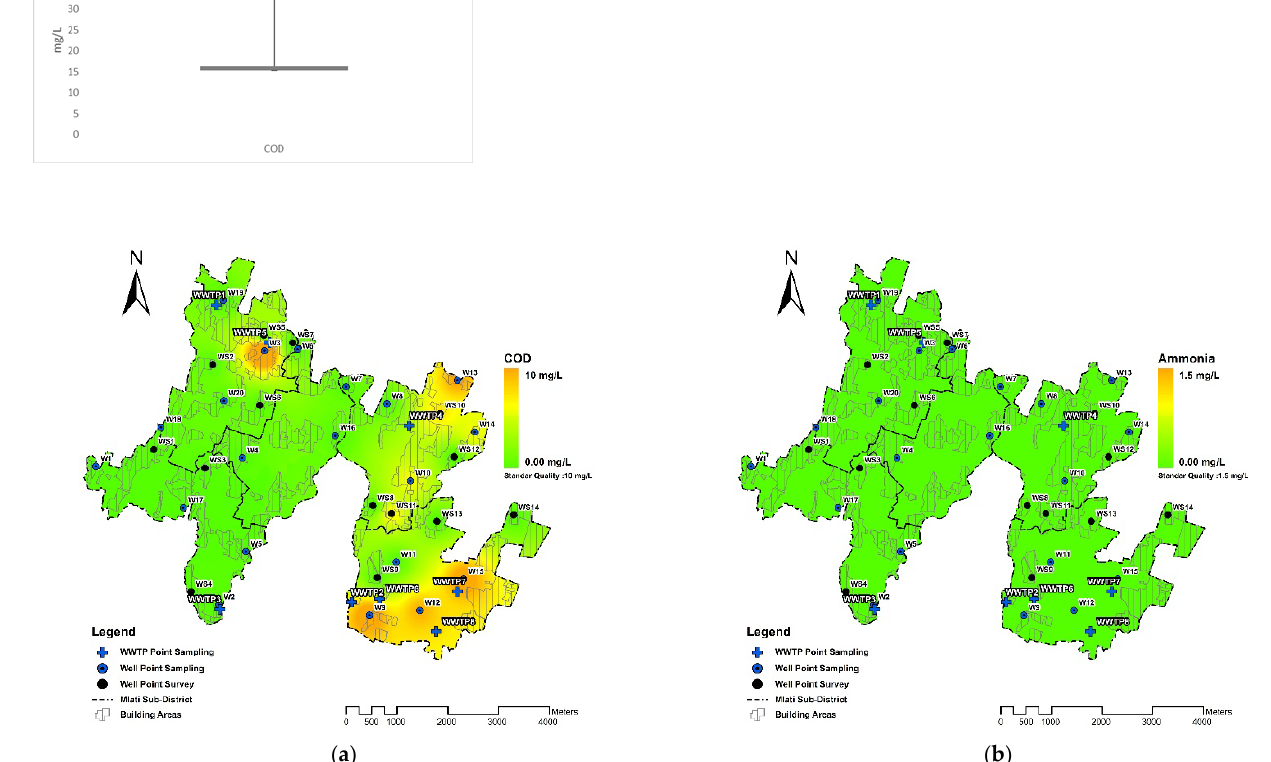
Figure 6. ( a ) COD and ( b ) Ammonia concentration and distribution